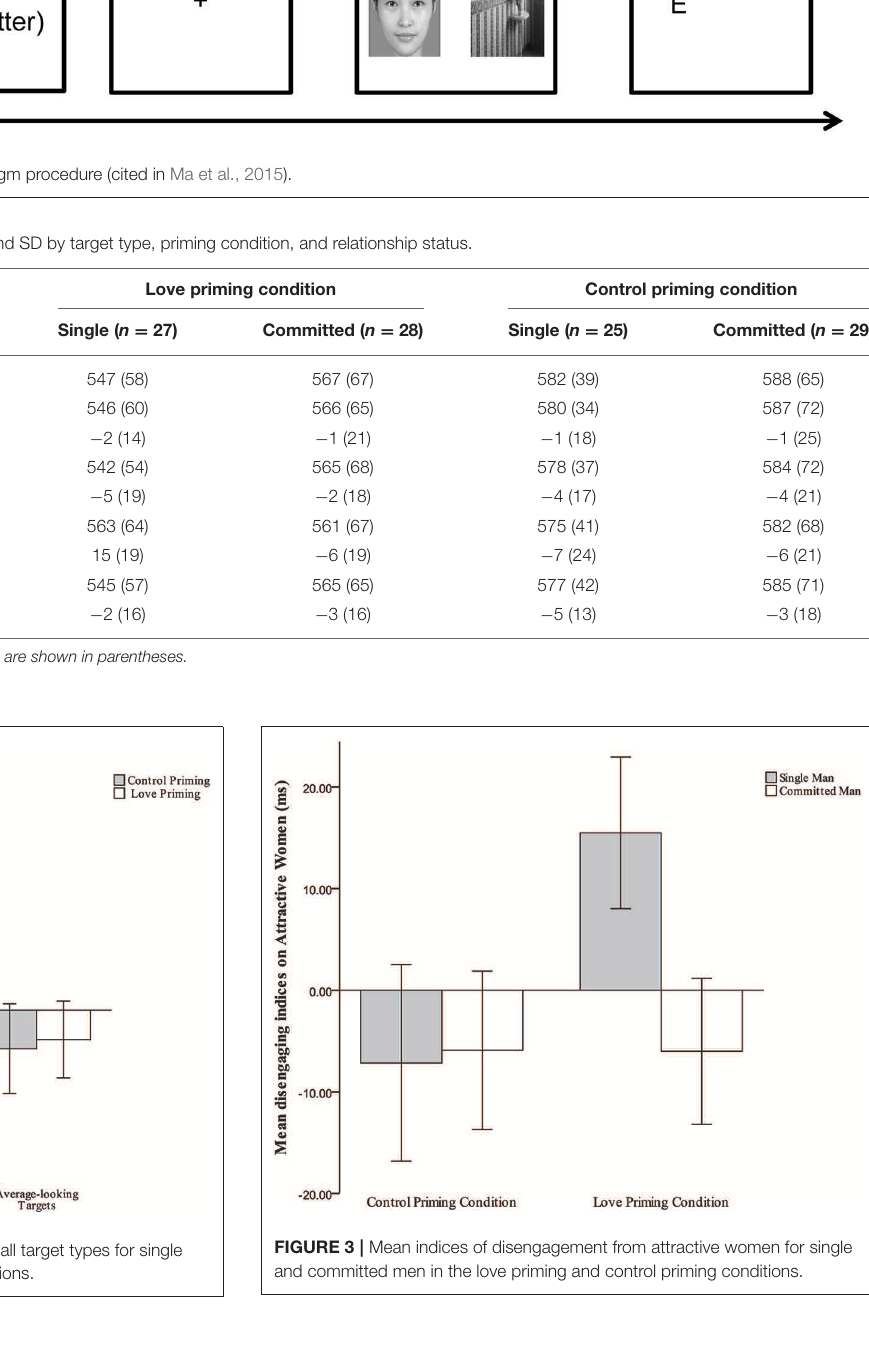
committed men’s data, specifically, a 2 (priming condition: love priming vs. control priming) × 3 (target type: attractive male vs.